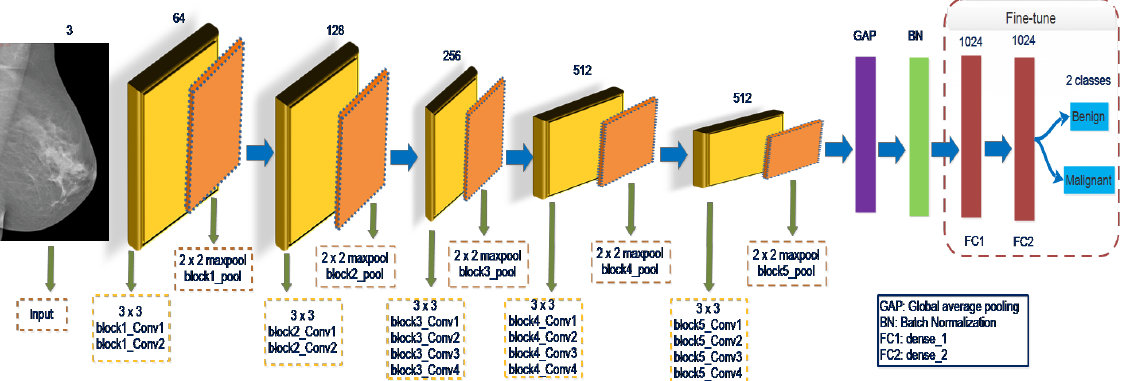
Figure 3. Representation of the network structure of the VGGNet19 model containing 19 layers. The global average pooling layers (GAP) and batch normalization layer (BN) are added and succeeded by FC1, FC2, and output layers. The weight is optimized to learn for the specific tasks during model